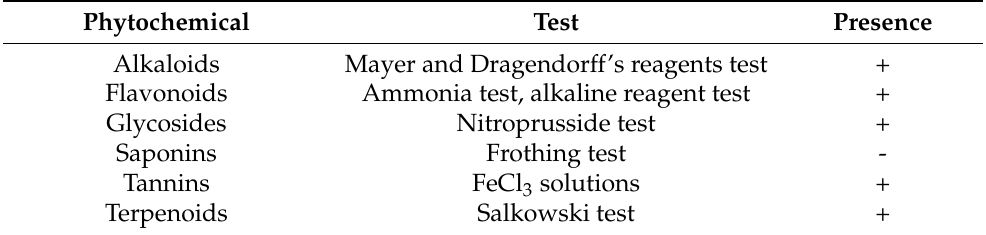
Table 1. The primary phytochemical analysis of Z. spina-christi methanolic extract.